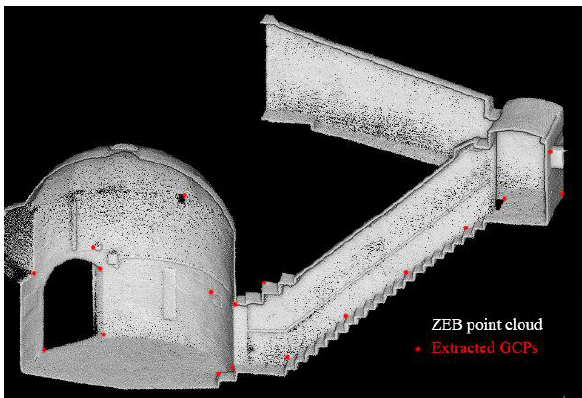
Figure 10. The portion of the SLAM point cloud used